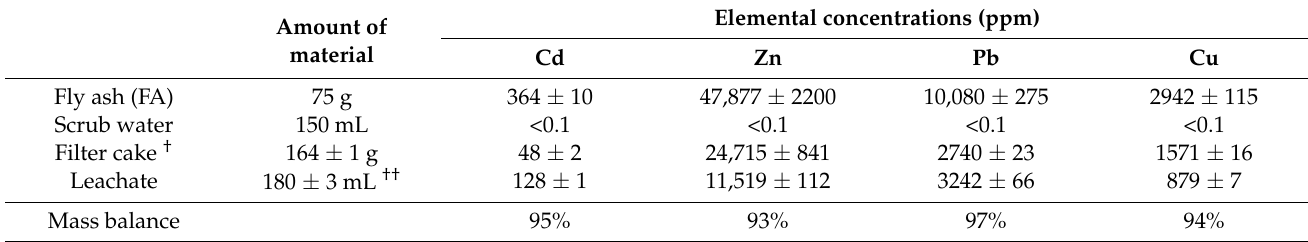
Table 4. Mass balance of laboratory-scale experiment